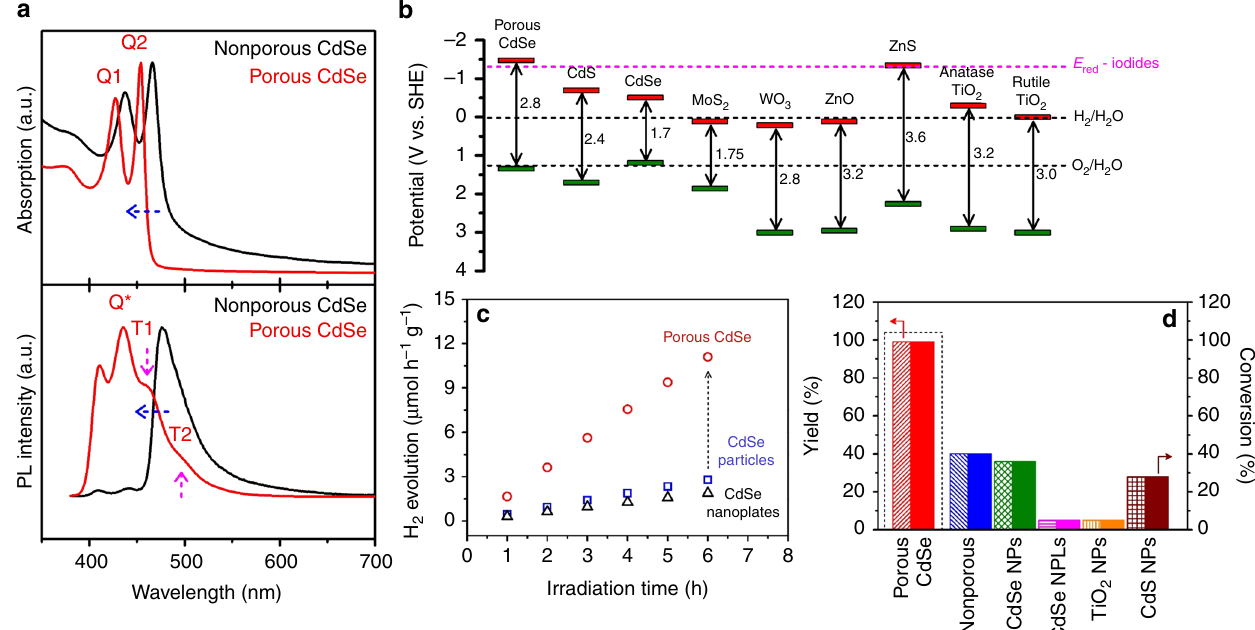
Fig. 3 Band structure and photocatalytic performance of porous CdSe nanosheets. a UV-Vis and PL spectra of porous and non-porous CdSe nanosheets; b band edge energies of various photocatalysts compared with redox energy levels for water splitting and for the reduction of aryl iodides; c a comparison of the PHE activities of porous CdSe, commercial CdSe nanoparticles, and nanoplates; and d comparison of the yields and conversions for